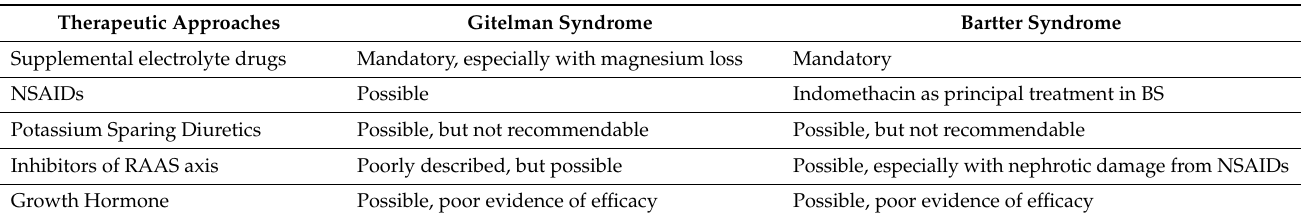
Table 4. Currently used pharmacological treatments for Bartter and Gitelman